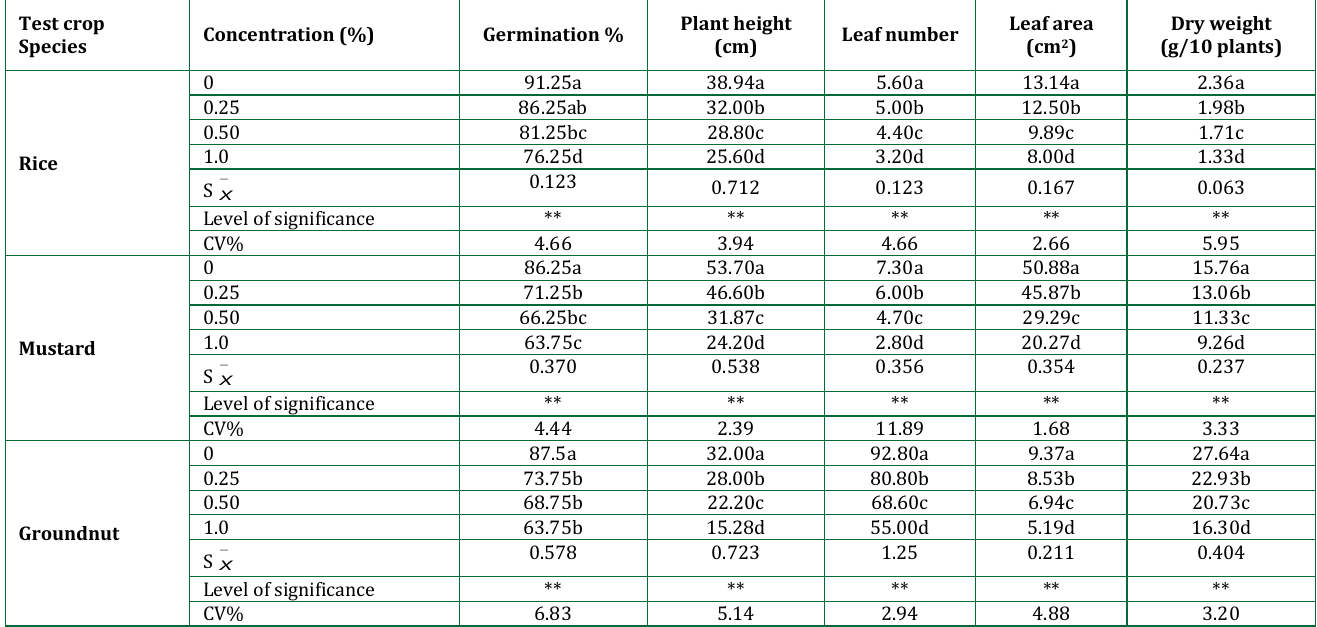
Table 1: Effect of different concentrations of Siam weed debris on seed germination and seedling growth of rice, mustard and groundnut Test crop